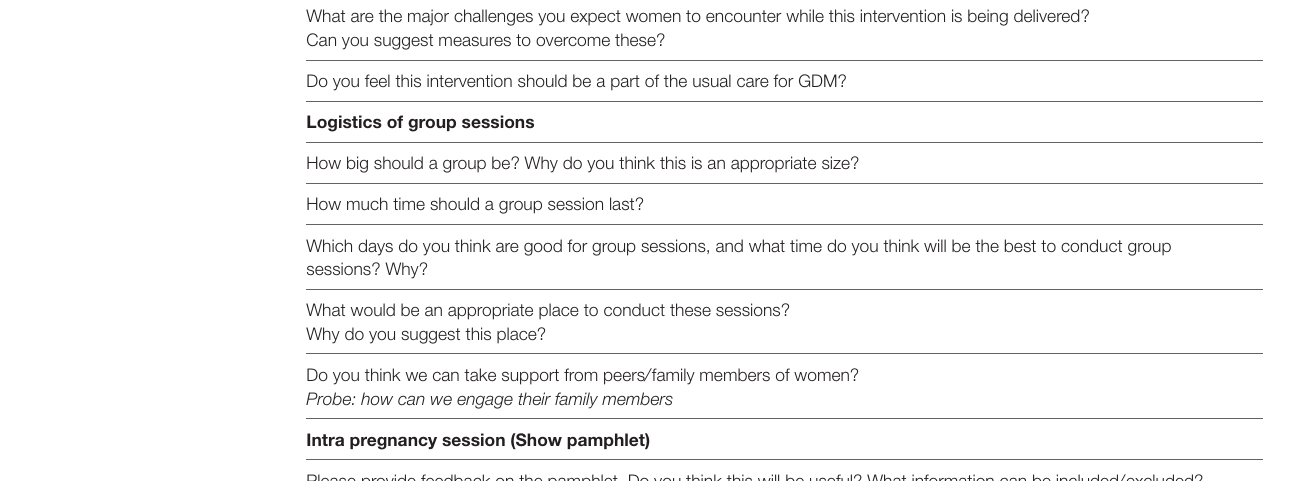
What are the major challenges you expect women to encounter while this intervention is being delivered? Can you suggest measures to overcome